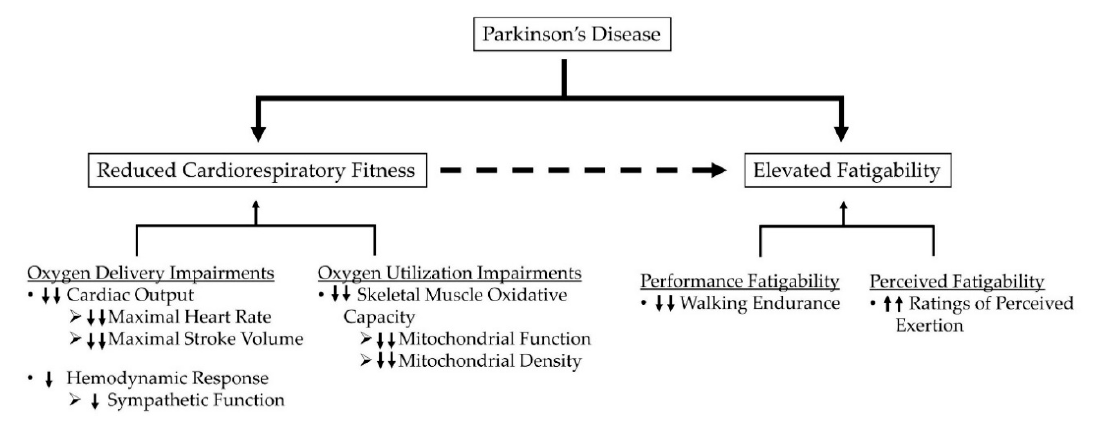
Figure 1. Hypothesized schematic representation of potential relationships between PD, fatigability, and cardiorespiratory impairments. Single arrows represent the impairments independently related to PD, while double arrows represent impairments related to the combination of PD and aging.